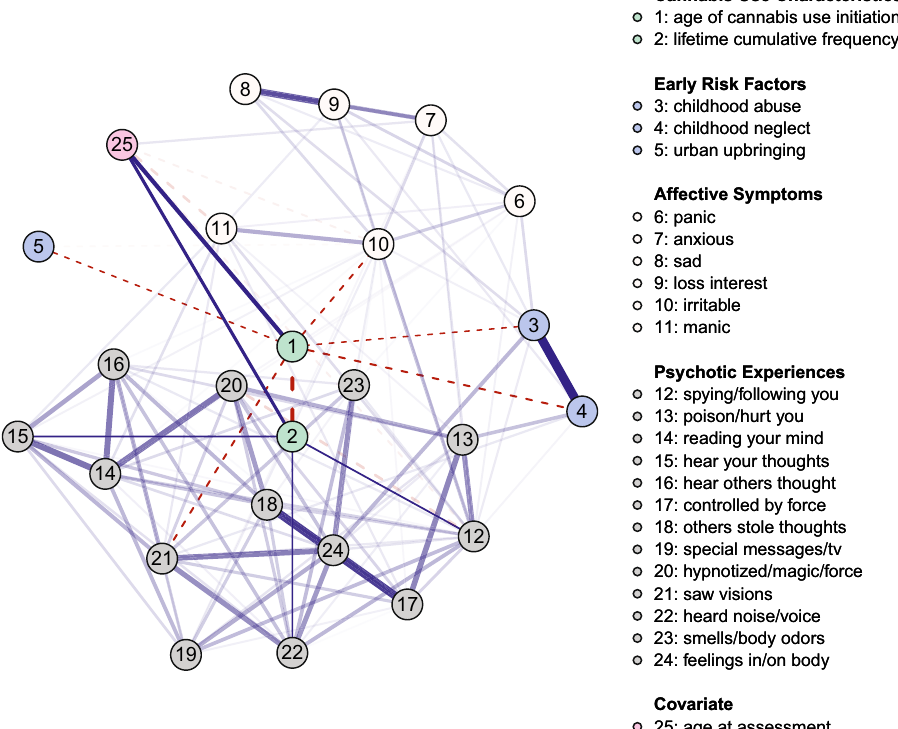
Figure 1. Network of cannabis use characteristics (age of cannabis use initiation, lifetime cumulative frequency of cannabis use), early risk factors, psychotic experiences, and affective symptoms ( N = 2,544). Solid blue (dashed red) lines represent positive (negative) associations between variables and wider, more saturated edges indicate stronger associations. Given that the focus of the paper was to investigate the relations between the cannabis use characteristics and aspects of psychopathology, the edges connecting to the two relevant variables (age of cannabis use initiation, lifetime cumulative frequency of cannabis use) have been manually un-faded, i.e., these edges were deliberately set opaque, while the edges between the other nodes in the network retain transparency. Variable groups are differentiated by